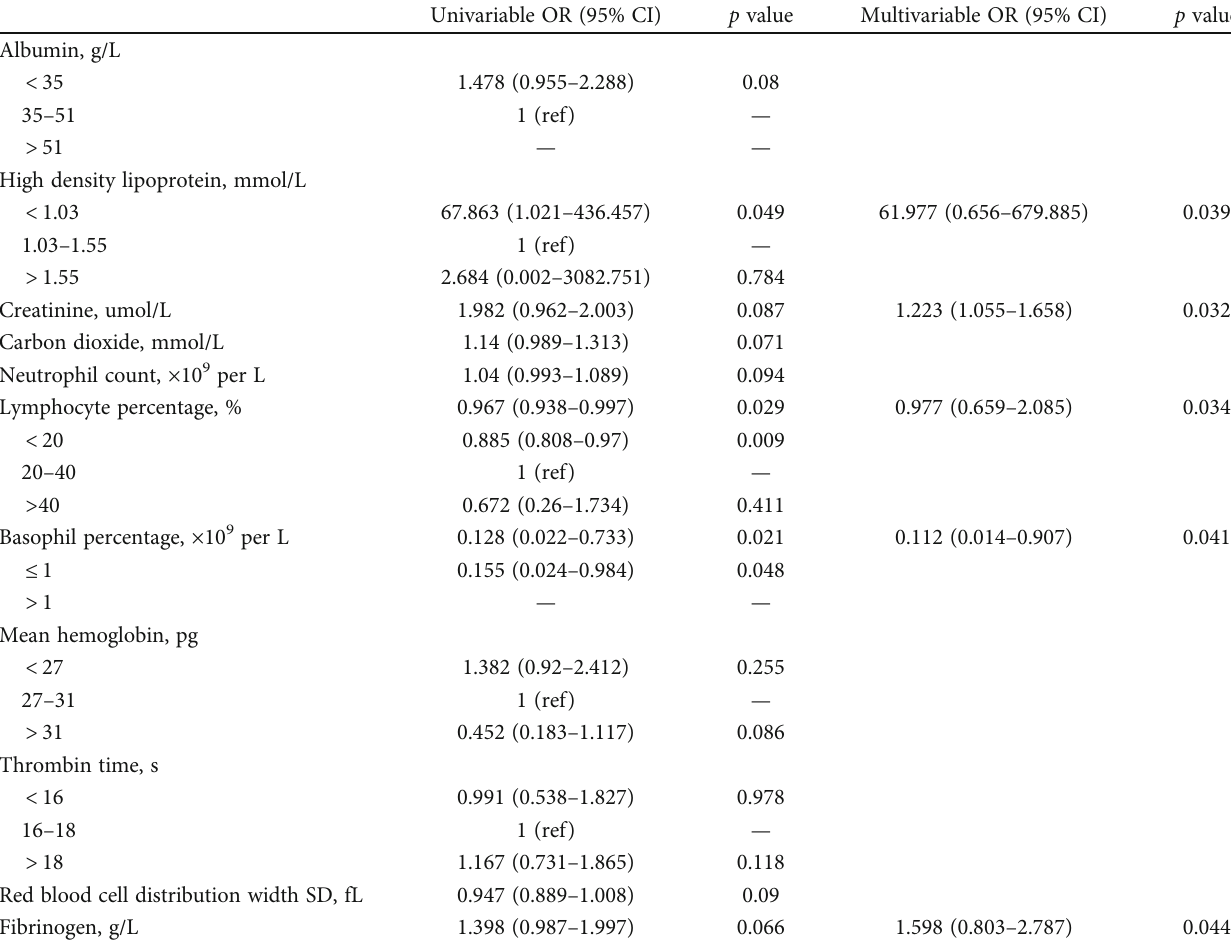
Table 6: Risk factors associated with male COVID-19 patients with